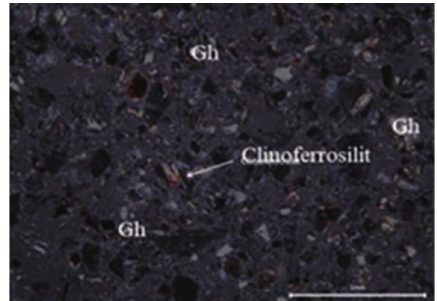
Figure 4: Microscopic image for ABS. Table 1: Quantities for materials within